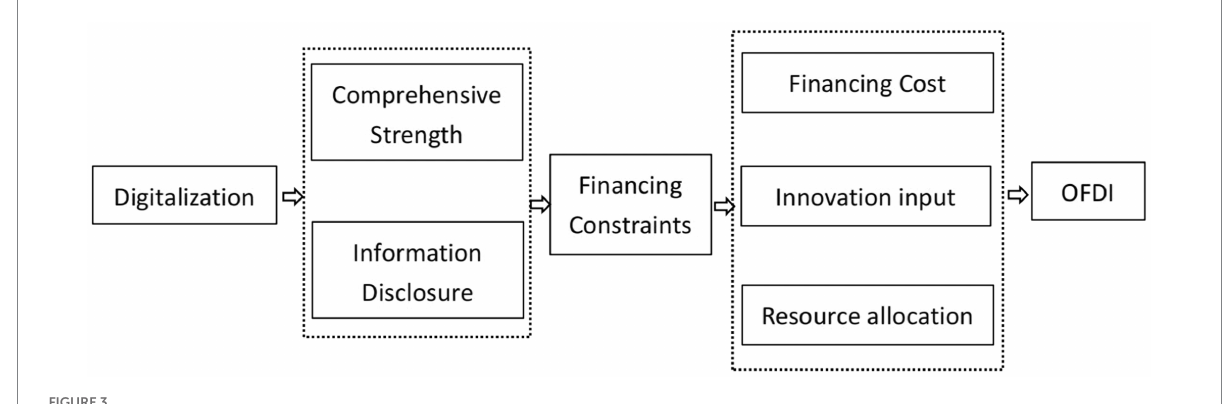
FIGURE 3 The mediating role of financing